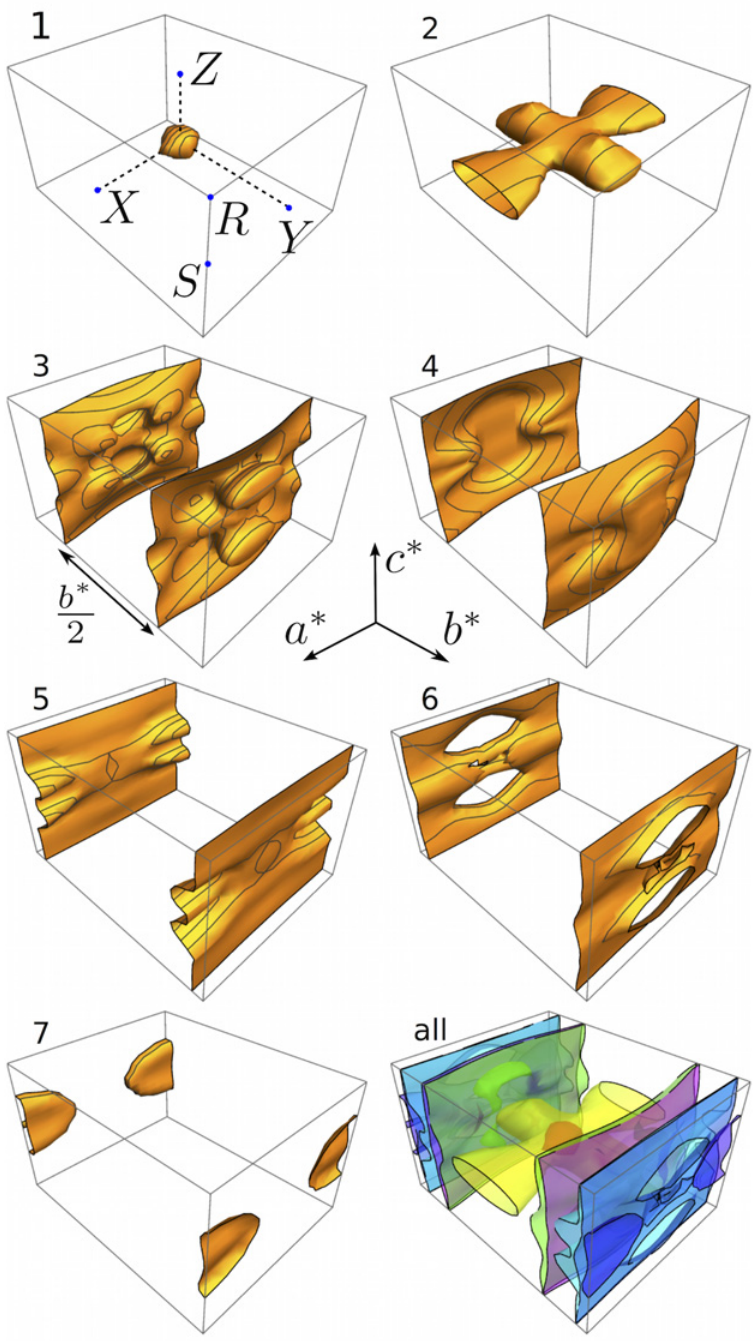
Fig 6. Calculated Fermi surfaces of CuFe 2 Ge 2 . The high symmetry points are marked in the first panel. Seven bands with Fe- d character cross Fermi level and bands numbered as 1, 3, 4, 5 have strong Fe 1 character and bands 2, 6, 7 have strong Fe 2